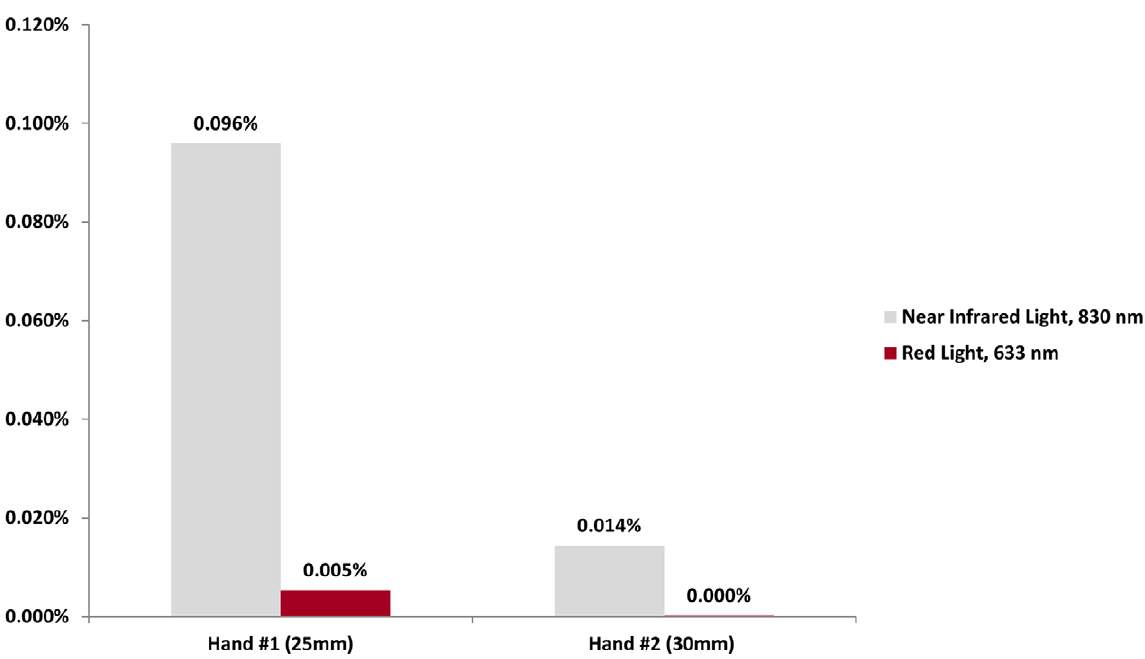
Figure 6. Percent Penetrance of Light through Human Hand invivo. Transmission of near infrared light through a human hand is low, but quantifiable, and is greater than red light transmission.